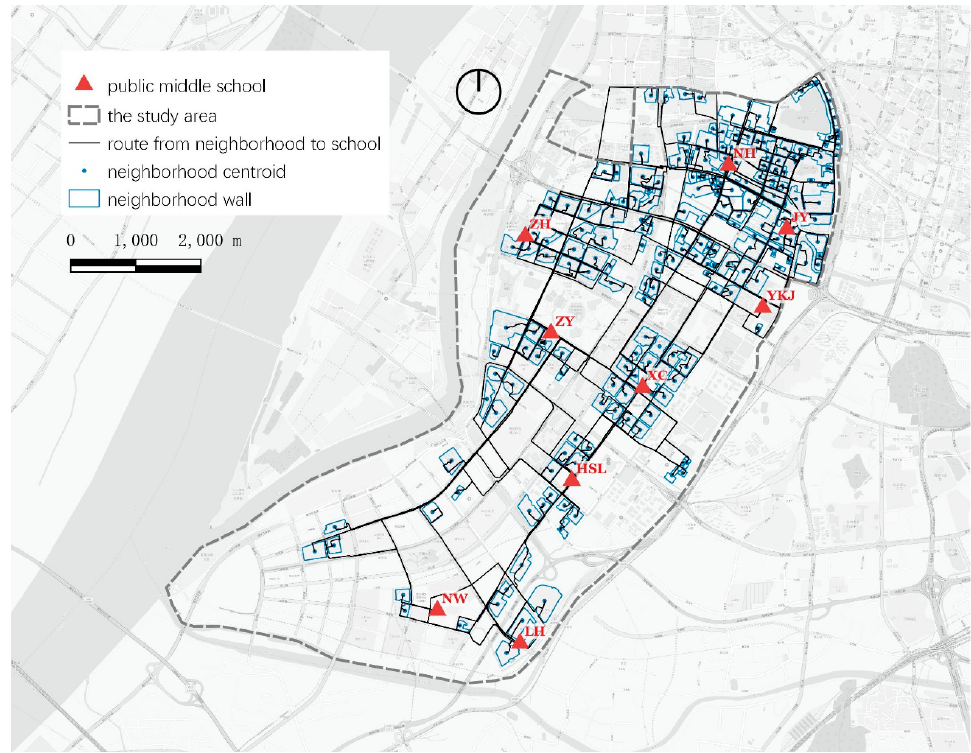
Figure 2. Routes from the centroid of each neighborhood to each public middle school.